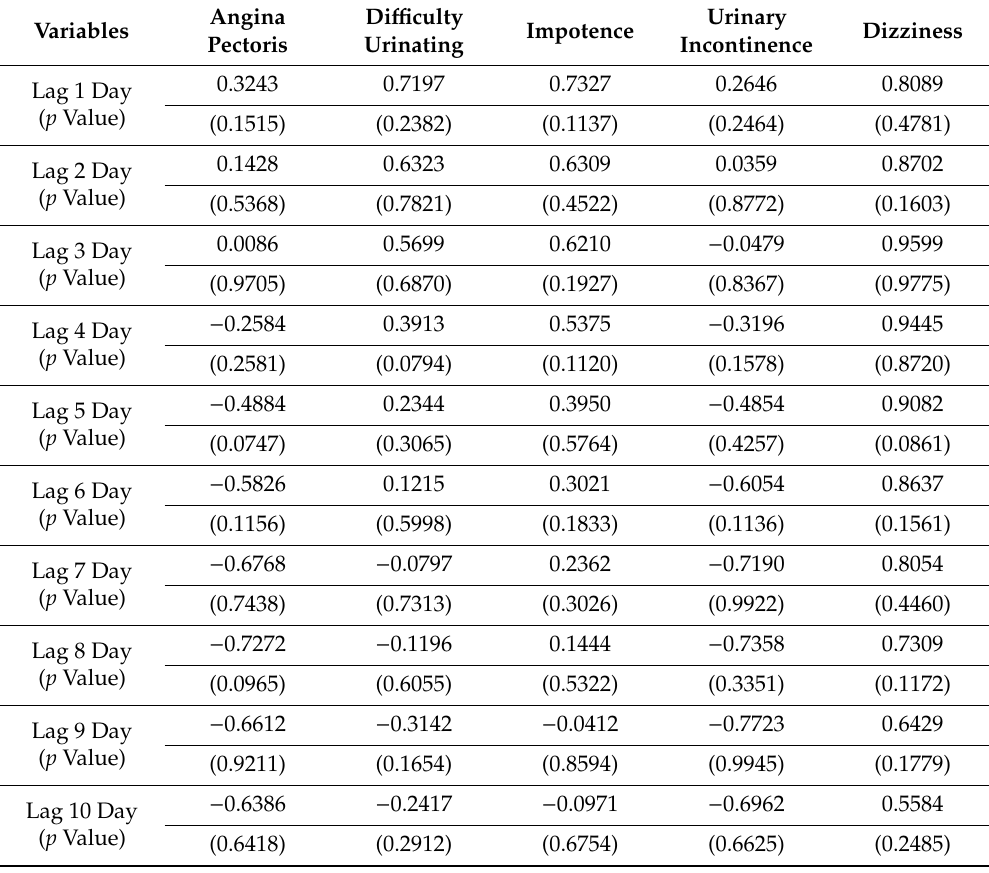
Table A1. Correlation between new-confirmed cases number and lag time series of five non-specific COVID-19